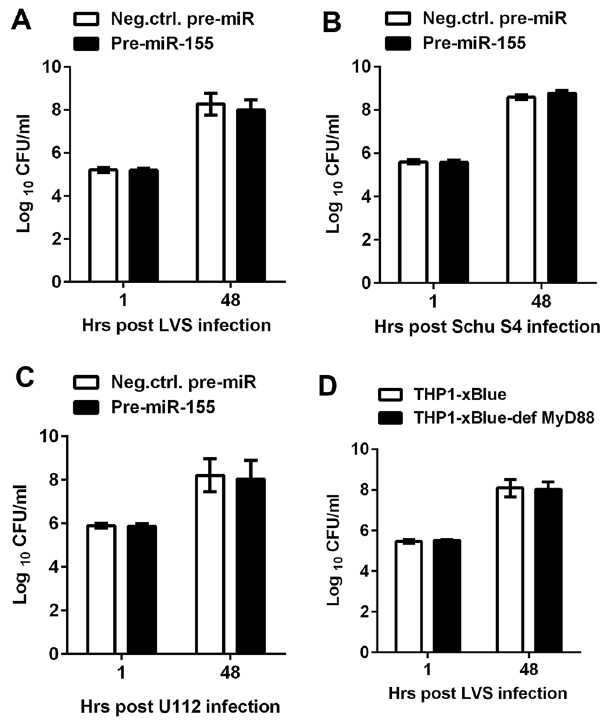
Figure 5. Neither miR-155 overexpression nor MyD88 deficien- cy alters F.tularensis replication in human macrophages. A–C . MDMs were infected with LVS (A), Schu S4 (B), or U112 (C) 48 h after transfection with miR-155-specific or negative control pre-miRs, and viable intracellular bacteria were quantified at the indicated time points by measurement of CFU. Data shown are the mean 6 SEM (n=3). D . LVS replicates normally in control (xBlue) and MyD88-deficient (x-Blue- def MyD88) THP-1 macrophages. Data are the mean 6 SEM